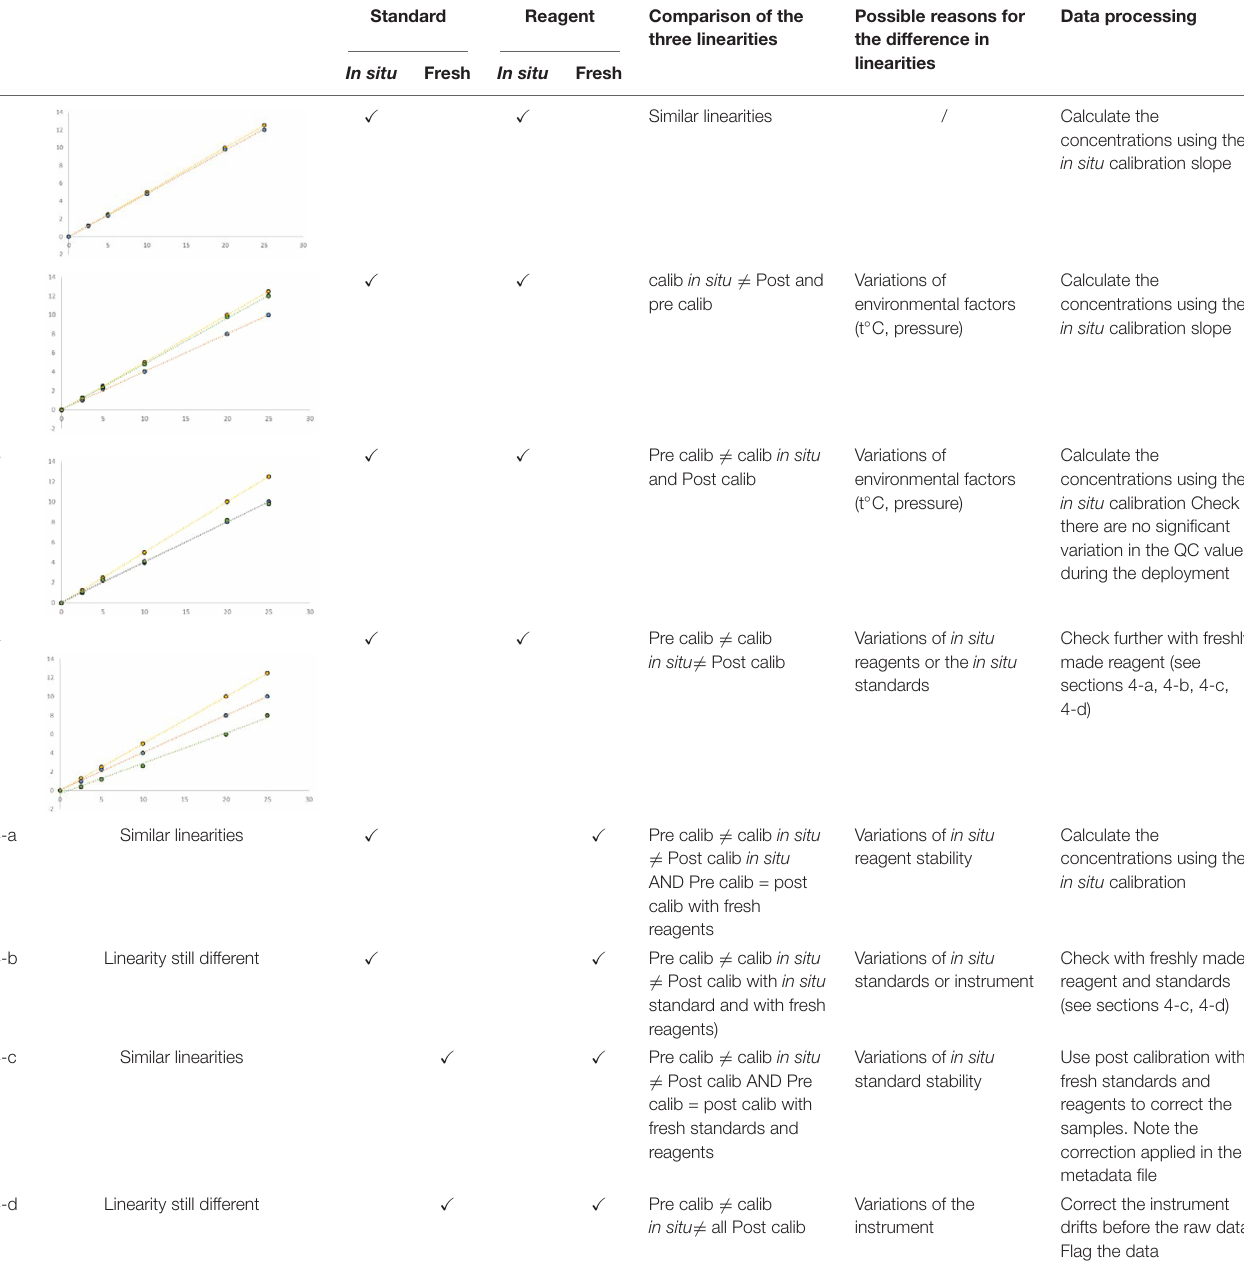
TABLE 6 | Comparison of the linearities obtained with the pre- (yellow dots), in situ (blue dots) and post- (green dots) calibrations made with in situ ∗ or freshly made reagents and standards. Standard